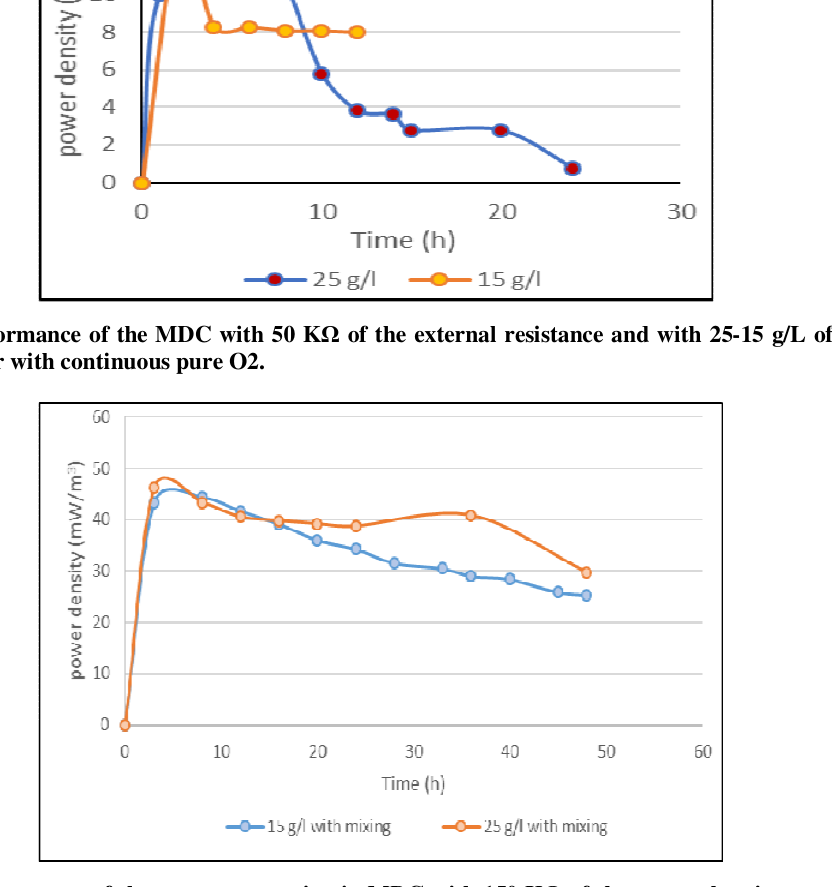
Fig. 3. show the performance of the power generation in MDC with 150 K Ω of the external resistance and with 25-15 g/L of NaCl in desalination chamber with